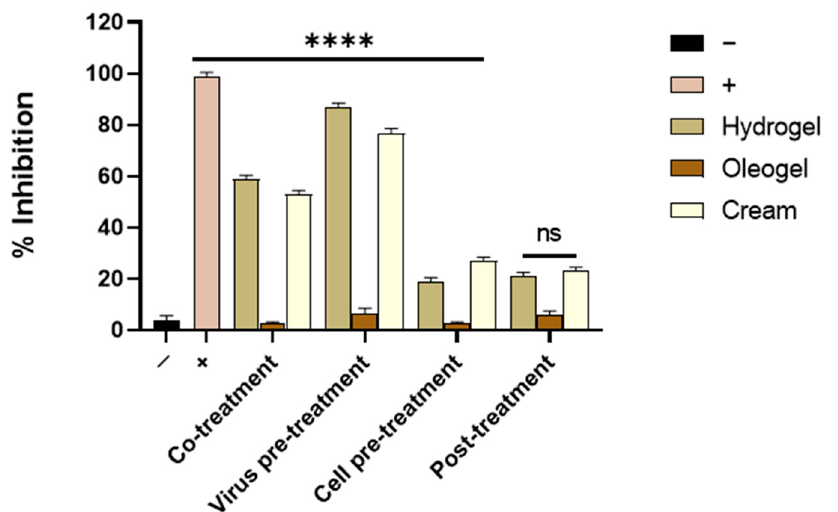
Figure 10. Antiviral activity of OFE formulations against acyclovir-resistant HSV-1. Hydrogel and cream formulations were able to reduce the viral infection by acting in co-treatment and virus pre-treatment assays. Statistical analyses were determined by ANOVA with Dunnett’s test for multiple comparisons. Significances are referred to as the negative control ( − ). **** p < 0.0001; ns: